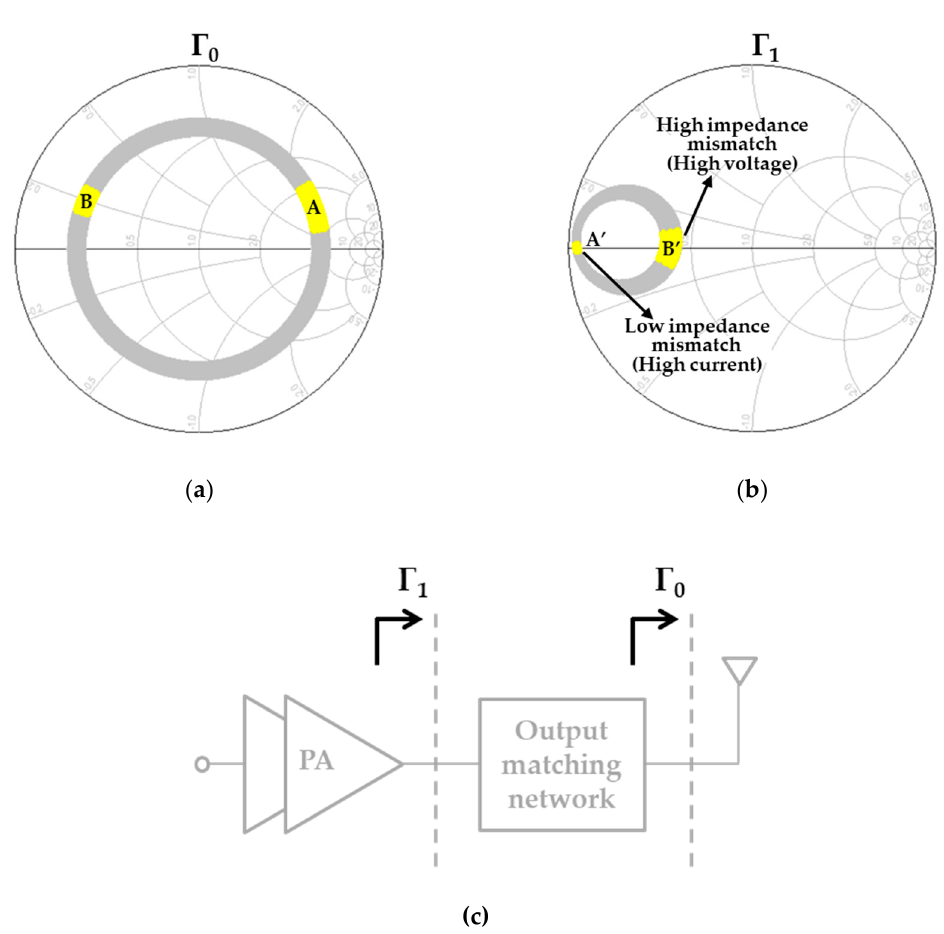
Figure 1. Two impedance mismatch cases that can cause power amplifier (PA) failures: ( a ) mismatched impedance at antenna terminal ( Γ 0 ); ( b ) mismatched impedance at PA’s final stage ( Γ 1 ); ( c ) reference planes of (a) and (b).